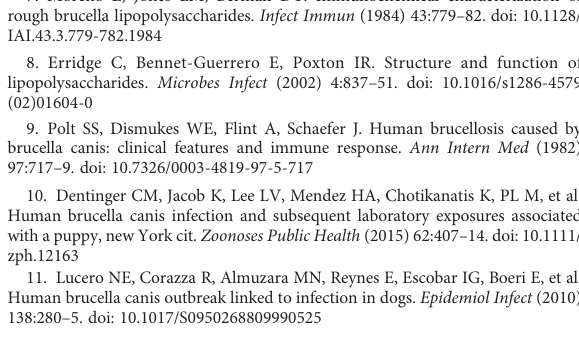
CFU of B. canis. The lungs were divided into 4 quadrants with the right cranial quadrant containing the right superior and middle lobes and the right caudal quadrant containing the right inferior and post-caval lobes. Data points represent the mean bacterial recovery in CFU per mL plus the standard deviation. Data were analyzed via one-way ANOVA and Tukey ’ s multiple comparisons test. SUPPLEMENTARY FIGURE 2 B. canis establishes a chronic infection following intratracheal inoculation comparable to B. abortus but with higher colonization than B. melitensis in the lungs. Colonization 6 and 9 weeks following inoculation of female C57BL/6J mice with 10 7 CFU B. melitensis, B. abortus , or B. canis , or PBS in the (A) spleen, (B)lungs,(C) mediastinal lymphnode (MdLN), (D)liver, (E) uterus, and (F) kidney. Data points represent the mean bacterial recovery in CFU per gram of tissue plus the standard deviation for all animals in each infection group at each time point. Data were analyzed using two- way ANOVA withSidak ’ smultiple comparisons test.Signi fi cantdifferences are depicted between infection groups (*p < 0.05, **p < 0.01, ***p < 0.001, ****p < 0.0001) and between infection groups and the PBS negative control group (##p < 0.01, ####p < 0.0001). SUPPLEMENTARY FIGURE 3 Intratracheal inoculation of mice with B. canis at 10 7 CFU results in less granulomatous in fl ammation in the liver than B.abortus or B.melitensis at the same dose. (A) Representative histologic images of the liver from each group at 2-weeks post-infection showing foci of histiocytic in fi ltration/ granulomas (arrows) in the left column (H&E stain, 10x magni fi cation, scale bar= 100 µm) and positive intracytoplasmic immunolabeling for Brucella antigen (arrows) within the granulomas in the right column (IHC with DAB chromagen, 40x magni fi cation, scale bar= 20 µm). (B) Quanti fi cation of % histiocytic in fi ltration within the liver at 2-weeks post-inoculation. Measurement of cytokines in liver homogenate supernatants at 2-weeks post-infection, including (D) IFN- g , (E) TNF- a , and (F) IL-10. Data were analyzed via one-way ANOVA and Tukey ’ s multiple comparisons test. Signi fi cant differences from B. canis 10 7 CFU are depicted (**p < 0.01, ***p < 0.001, ****p < 0.0001) and between infection groups and the PBS negative control group (##p < 0.01, ####p < 0.0001). SUPPLEMENTARY FIGURE 4 Gating strategy for evaluation of single or simultaneous production of TNF- a , IFN- g , and IL-2 by CD4+ and CD8+ T-lymphocytes in mice following primary or secondary intratracheal inoculation with Brucella spp. Single cells were gated based on viability and T-lymphocytes were selected by double expression of CD45 and CD3. CD4+ and CD8+ populations were then separately analyzed or production of the three